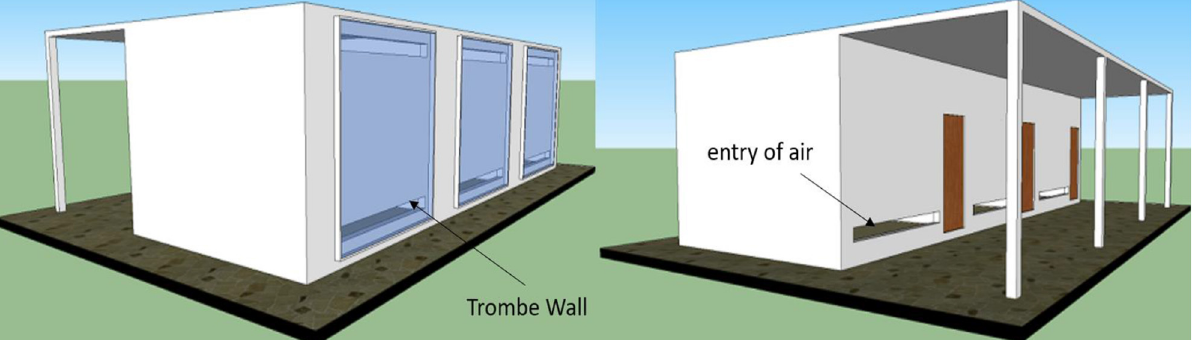
Fig. 3. Digital model.